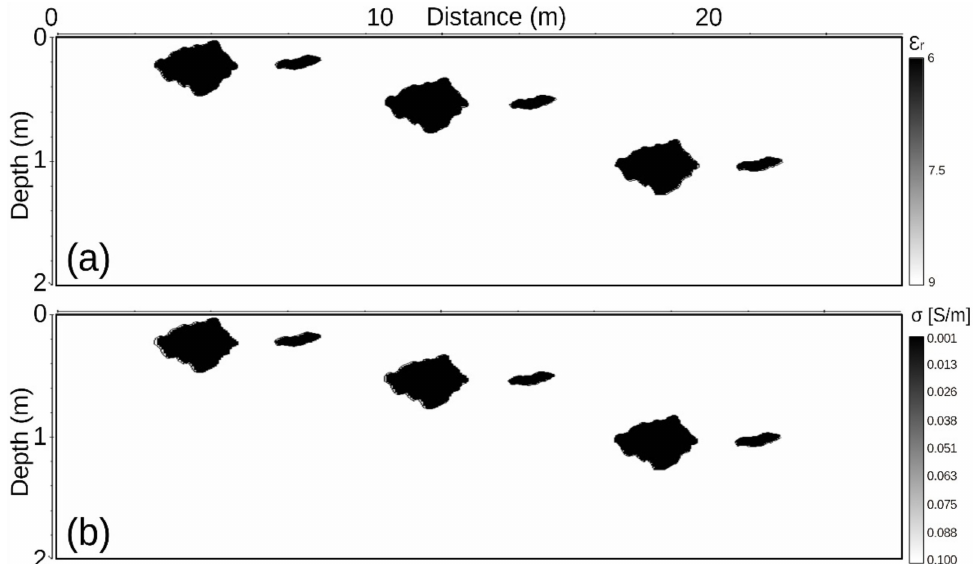
Figure 6. Model 1 with simulated cololites and fossil remains of different size locating at increasing depth down to ~1 m; details of the parameters used are reported in Table 3: ( a ) relative dielectric permittivity properties assigned to media and ( b ) same model displaying the conductivity values assigned to